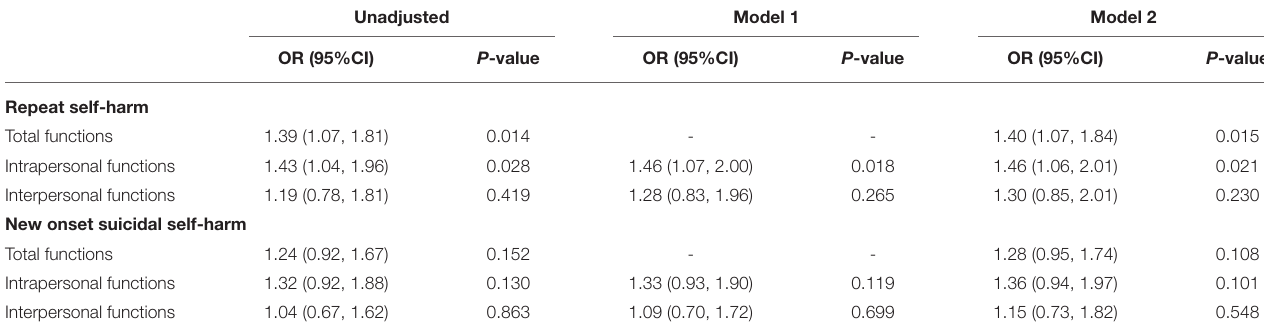
TABLE 4 | Functions of NSSH as predictors of future self-harm and suicide attempts: imputed